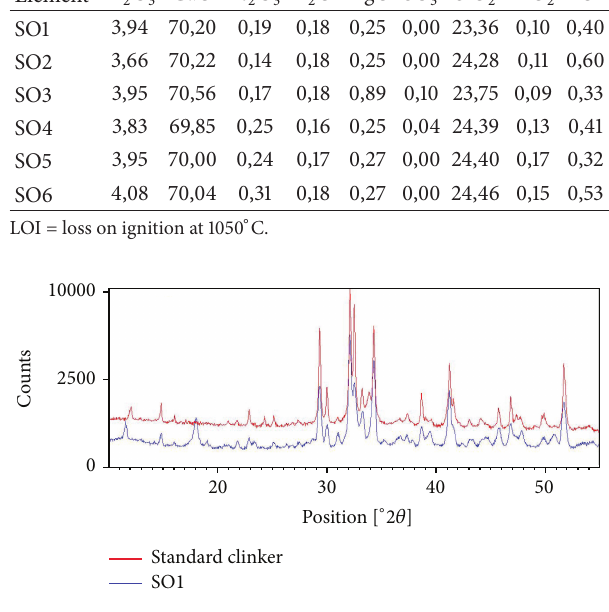
Figure 2: XRD pattern of sample 1 (SO1) clinker (blue) and a good quality standard clinker